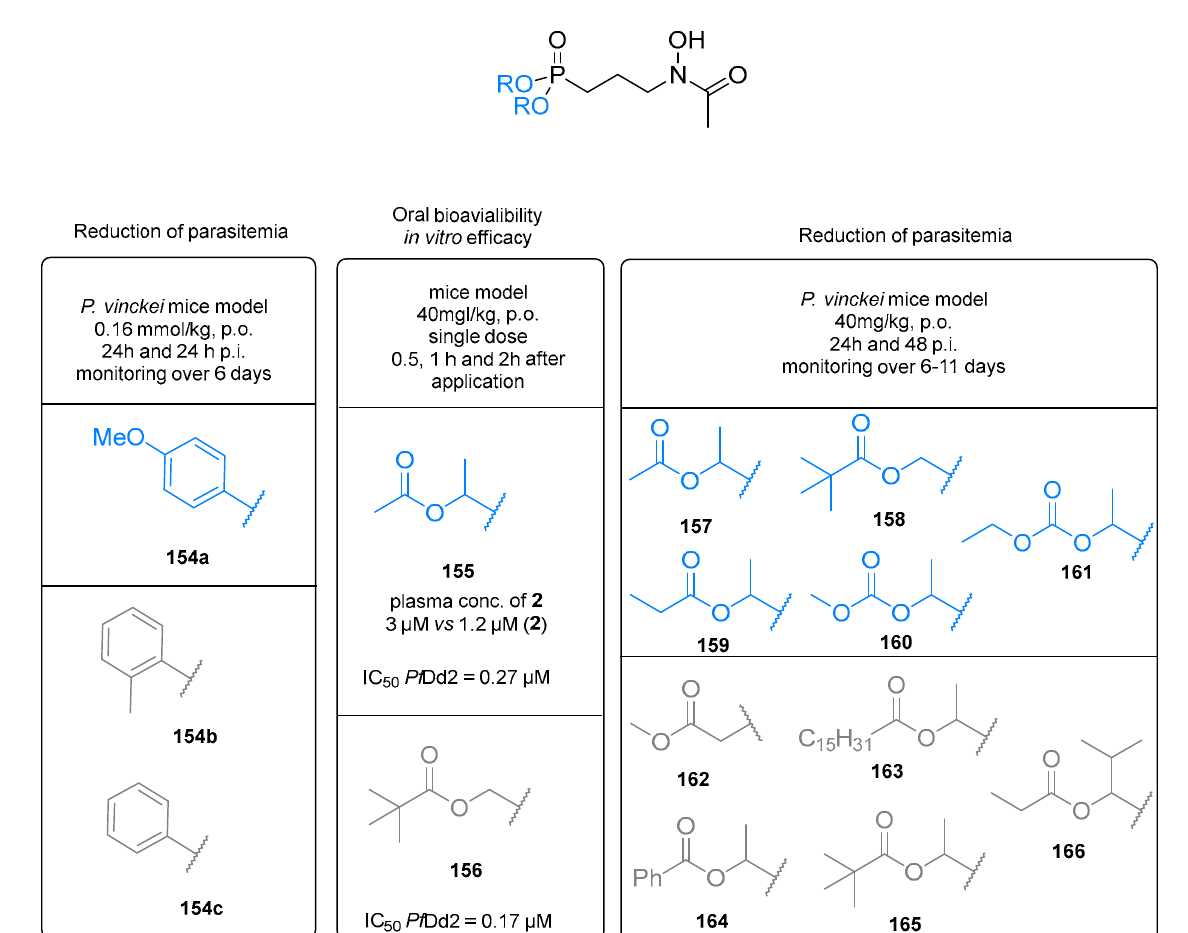
Figure 31. Results of in vivo studies of lipophilic FR900098 ( 2 ) esters. Blue indicates improvement and grey reduction of efficacy/plasma concentration of the prodrug compared to parent compound 2 . p.o. = per os, p.i. = postinfection.